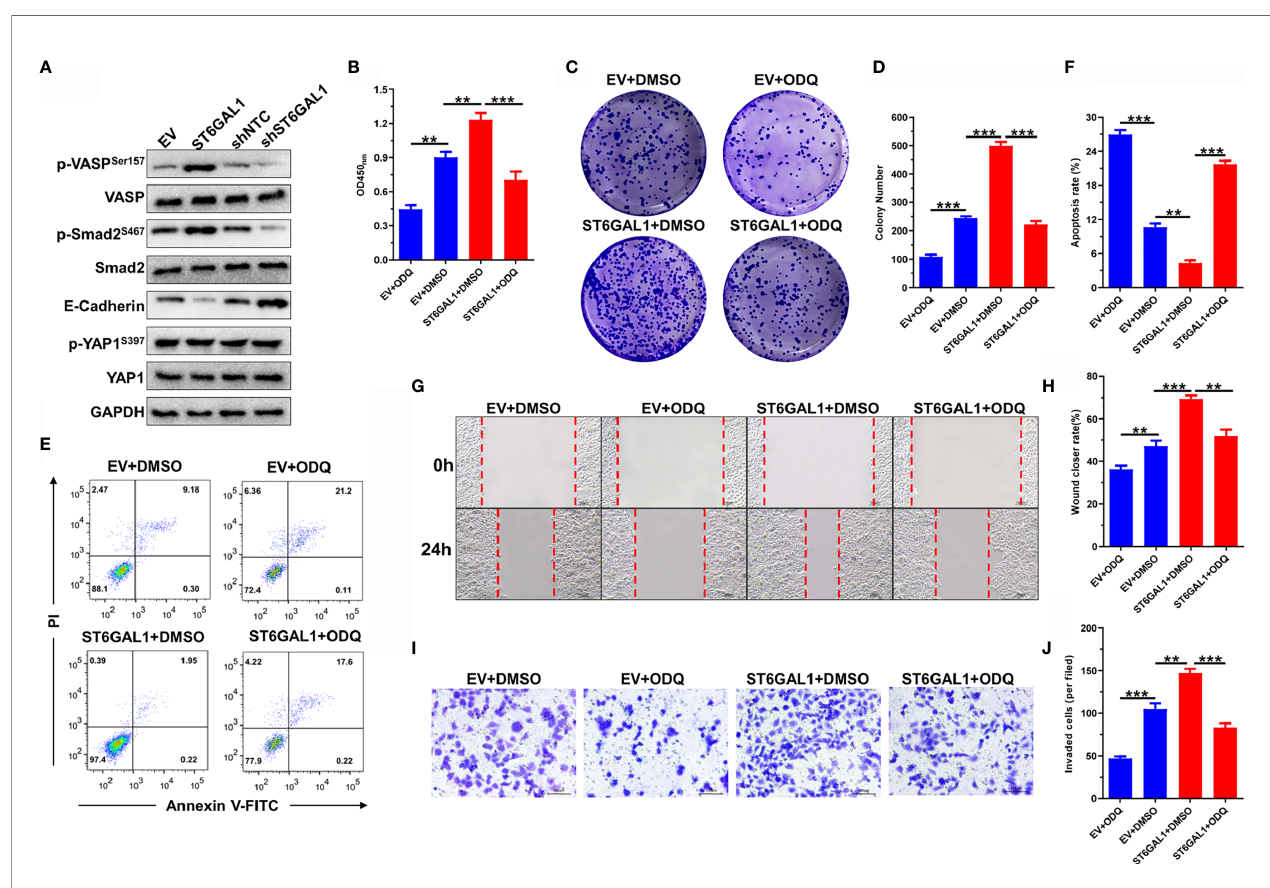
FIGURE 5 | ST6GAL1 activates cGMP/PKG signal axis to play oncogenic activities. (A) C33A cells were transiently transfected with pcDNA3.1-ST6GAL1 overexpressing plasmid (ST6GAL1), empty vector (EV), short hairpin RNA targeting ST6GAL1 (shST6GAL1), or a non-targeting control (shNTC). Forty-eight hours later, expression of classic proteins involved in TGF- b , cGMP/PKG, and Hippo signaling pathways were detected by Western blot. (B) Proliferation of indicated cells were detected by CCK-8 assay. (C) The clones of indicated cells were visualized by crystal violet staining. (D) Statistical analysis of colony numbers in C33A cells received indicated treatment. (E, F) Apoptosis of indicated cells were detected by fl ow cytometry, and then, apoptotic rates were statistically analyzed. (G, H) Migrative abilities of indicated cells were detected by wound-healing assay and statistically analyzed. (I, J) Invasive abilities of indicated cells were detected by Transwell assay and statistically analyzed. Data were presented as mean ± SD from the three independent replicates. ** p < 0.01; *** p <